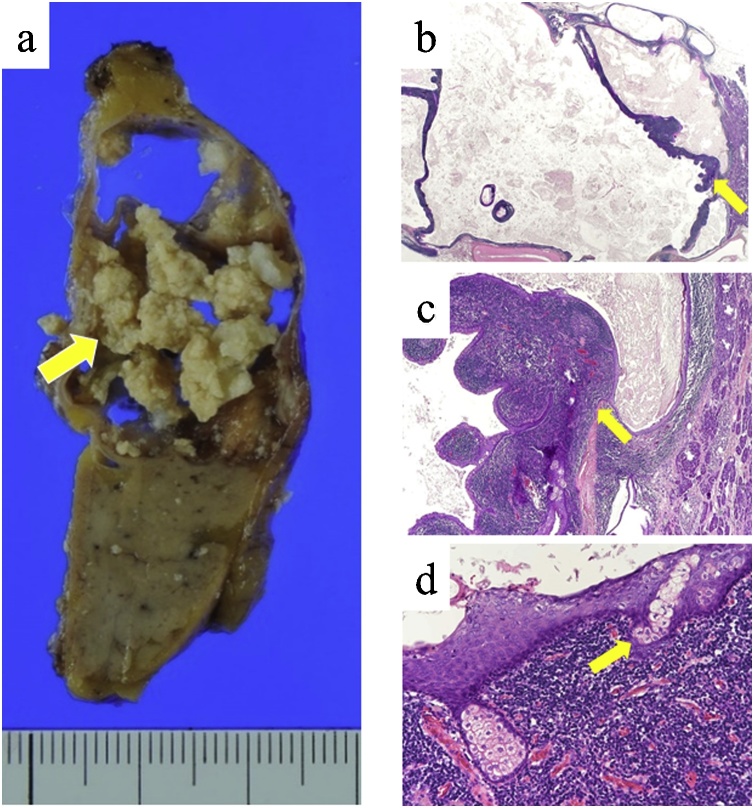
Histopathology: A. The cut surface of the resected specimen showed a multilocular cyst with solid nodules (arrow). B. The cyst was separated by a band of lymphoid tissue (arrow) (hematoxylin & eosin [H&E] stain ×10). C. The cystic wall was primarily lined by stratified squamous epithelium, and the cyst contains keratinized material. Several subepithelial lymphoid follicles could be observed (arrow) (H&E stain ×40). D. Sebaceous glands could be observed within the stratified squamous epithelium (arrow) (H&E stain ×400).